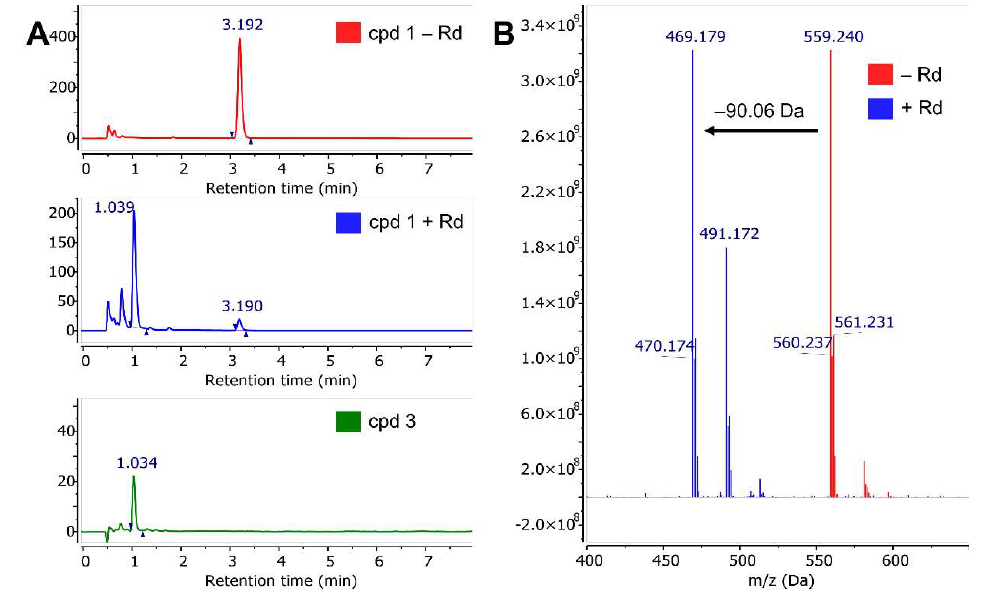
Figure 8. Hydrolysis assay to investigate the ester hydrolysis prodrug concept. A ) Exemplarily, the chromatograms for cpd. 1 are shown. Cpd. 1 hydrolyzed with rhodesain (blue, t R = 1.03 min) shows the same retention time as the reference cpd. 3 (green, t R = 1.03 min). The negative control incubated without rhodesain shows only the educt peak of cpd. 1 (red, t R = 3.19 min). B ) Analysis of the mass spectrum reveals the loss of a 90 Da fragment, matching the mass and isotopic distribution of the predicted enzymatic benzyl ester hydrolysis ([cpd 1 +H] + = 559.2 m/z; [cpd 3 +H] + = 469.2 m/z).